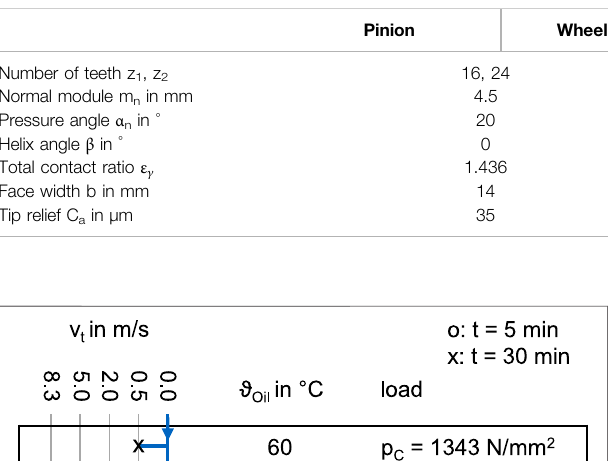
TABLE 2 | Main gear parameters of test gear of type C mod .